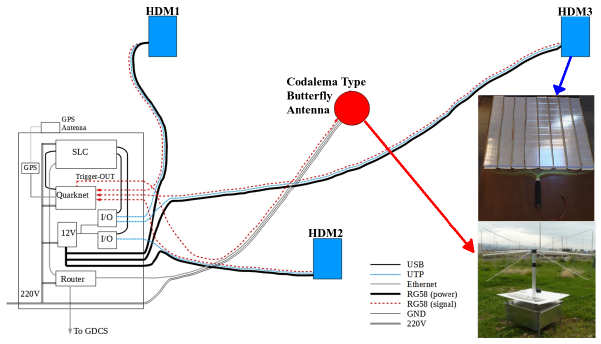
Figure 2. Schematic representation of the connections in the Astroneu station. Picture taken from